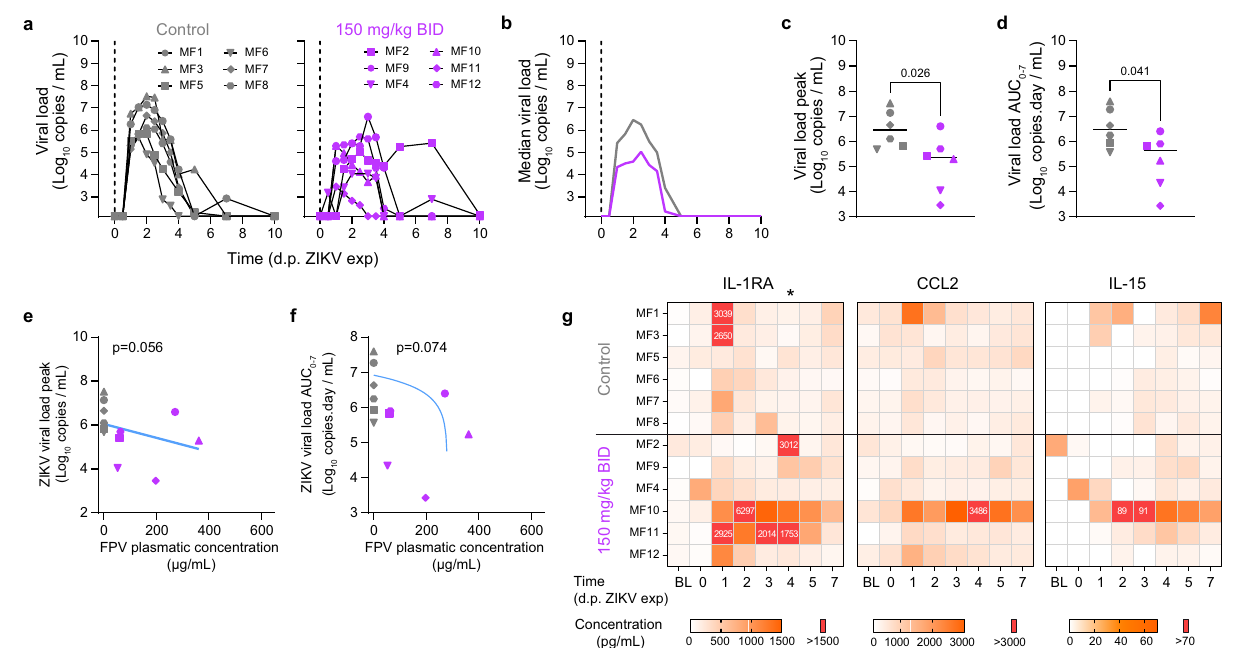
Fig. 3 | Viral kinetic and pharmacokinetic in ZIKV infected cynomolgus maca- questreatedwithFPV.a IndividualplasmaviralloadsdeterminedbyRT-PCRinall animals; b Median plasma viral load values observed in each treatment group; c , d Viral kinetic parameters (peak and AUC viral load) during the fi rst 7 days of infection. Median value is indicated by horizontal bar. Parameters were compared between groups using the two-tailed non-parametric Mann – Whitney test. e , f Viral kinetic parameters (peak and AUC viral load between 0 and 7 dpi) according to geometric mean FPV plasma trough concentration. Grey: untreated;